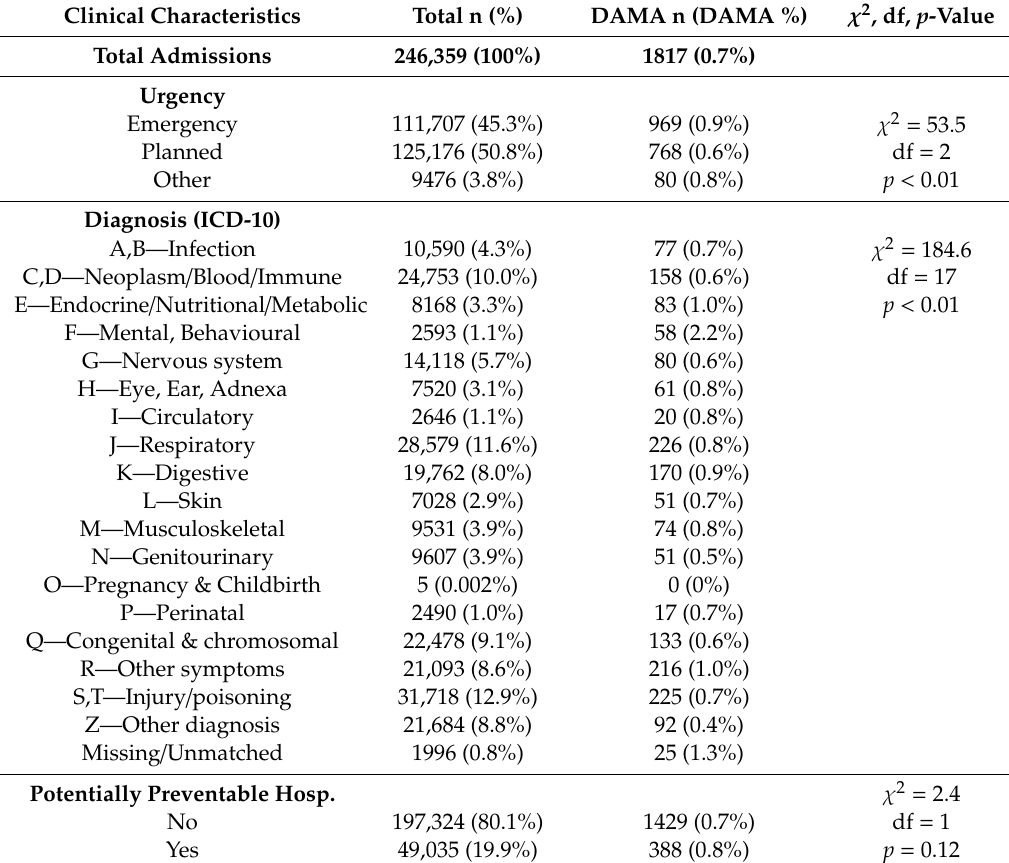
Table 2. Clinical characteristics (by number of